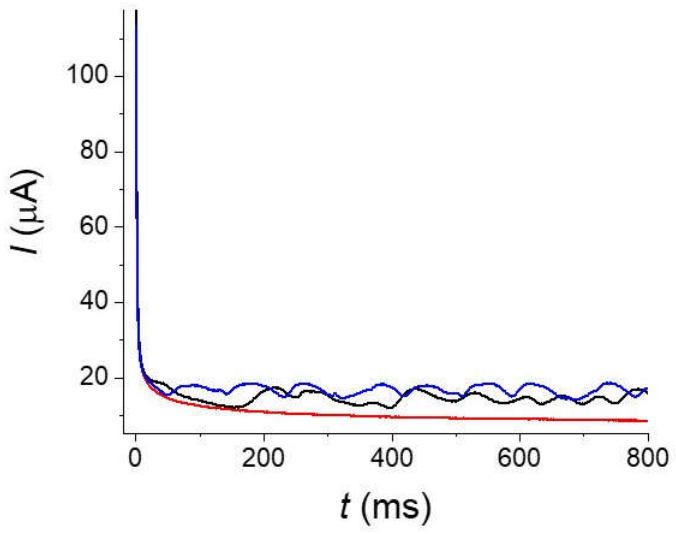
Figure 10. Chronoamperogram of a 10 − 1 mol L − 1 solution of potassium ferrocyanide at pH 13 in KOH under different stirring. Stationary solution (red), 200 RPM (black), 600 RPM (blue).